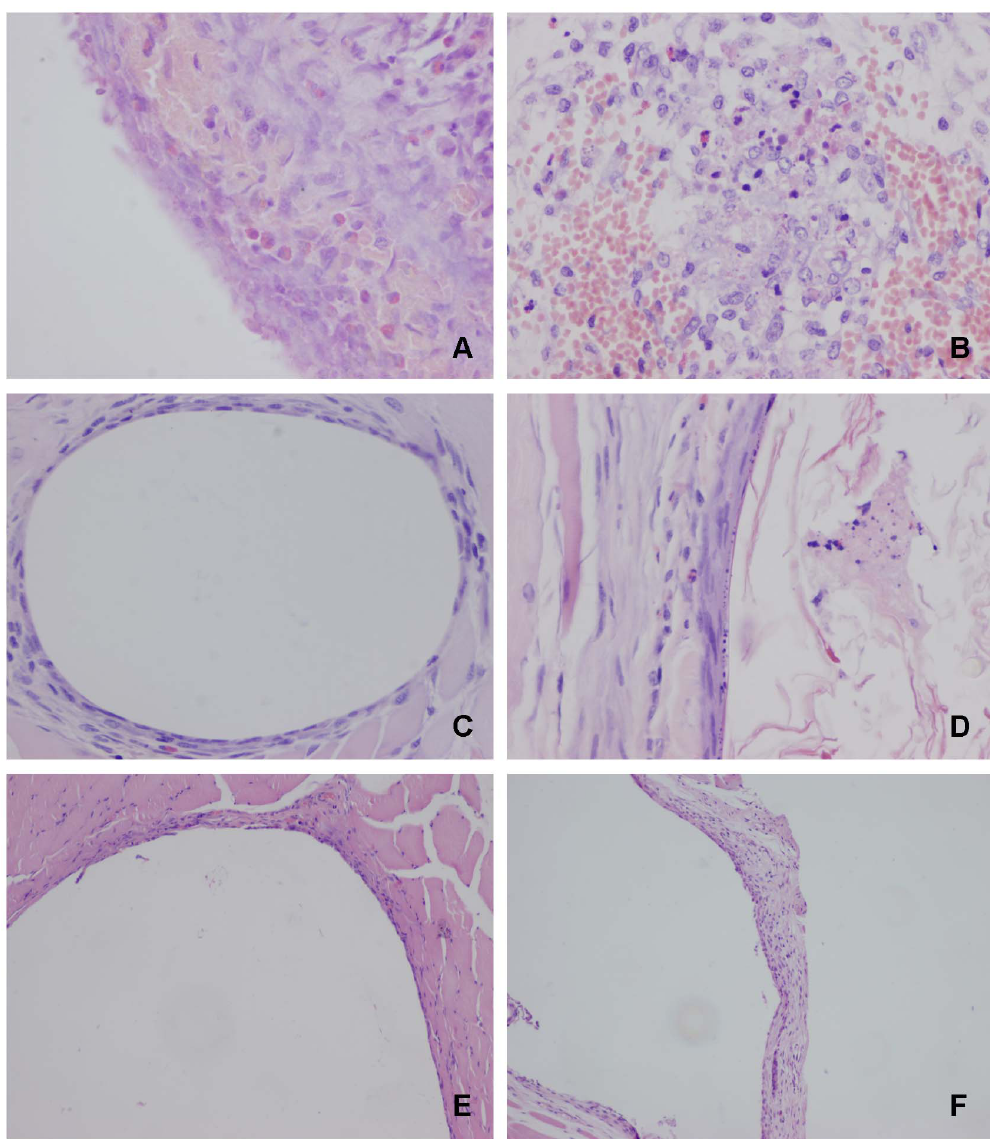
Figure 5. Light micrographs of muscle implantation histologic sections. Light micrographs of the nano-Cu/LDPE composite (B, D, F) which was implanted into the spinal muscle of adult rabbits compared with LDPE control material (A, C, E) for 1 (A, B), 4 (C, D) and 12 weeks (E, F). At 1 week, acute inflammatory reaction was the main characteristic (A, B) ( 6 400). A lot of heterophil granulocytes and a small amount of lymphocytes infiltration were seen around the nano-Cu/LDPE implant, but without formation of complete capsule (B). Similar inflammatory reaction was observed on the LDPE composite side (A). After 4 weeks of implantation, the number of heterophil granulocytes decreased sharply, and lymphocytes were seldom. Fibrous capsules formed on the test and control materials surface were clearly observed (C, D) ( 6 200). At 12 weeks, the inflammatory reaction of the two group sites had almost disappeared. Furthermore, the surrounding fibrous capsule had become more thinning and stable (E, F) ( 6 100).